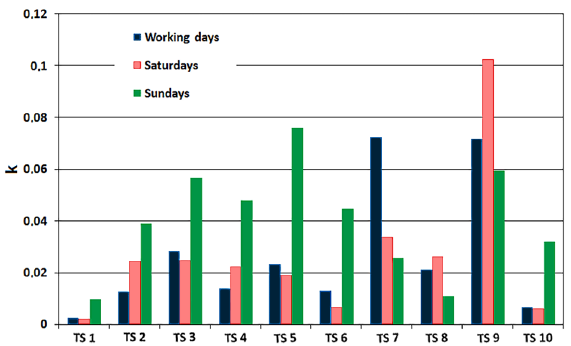
Fig. 13. Relative time of exceeding 770 V voltage of traction substations